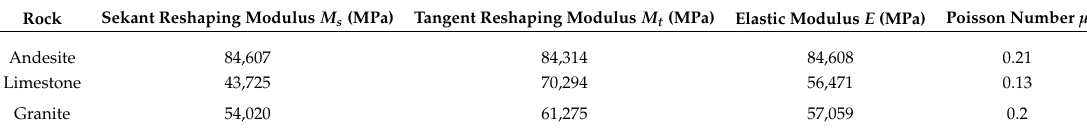
Table 3. Detailed mechanical properties of the rocks.